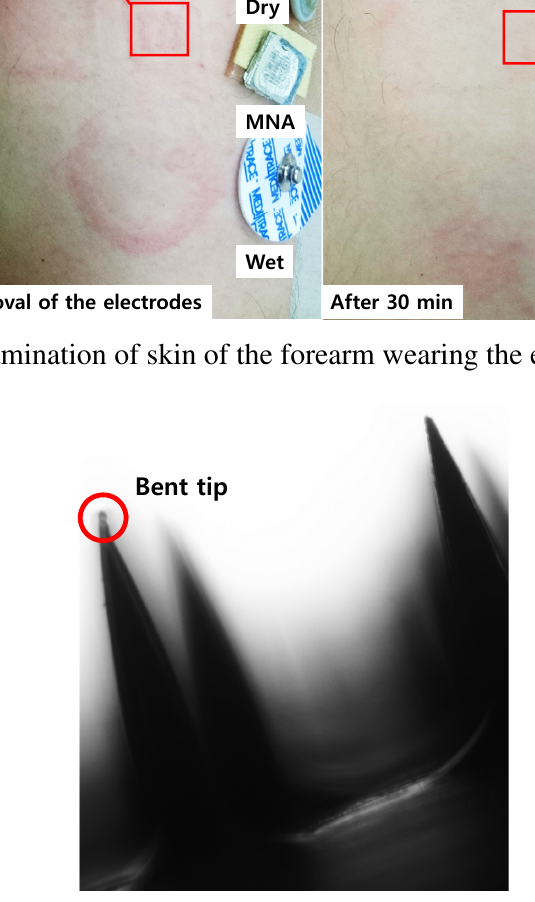
Figure 5. Needle tip condition after the annealing process.